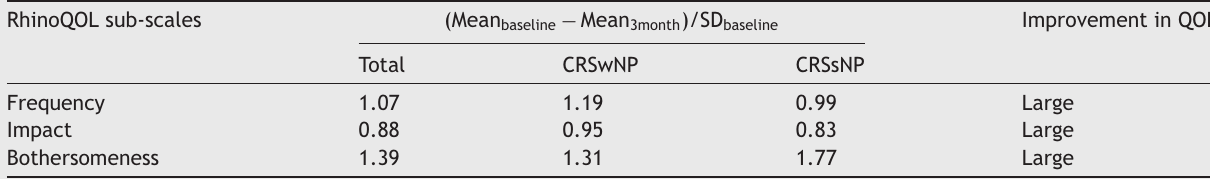
Responsiveness: magnitude of effect --- total sample and by type of CRS. RhinoQOL